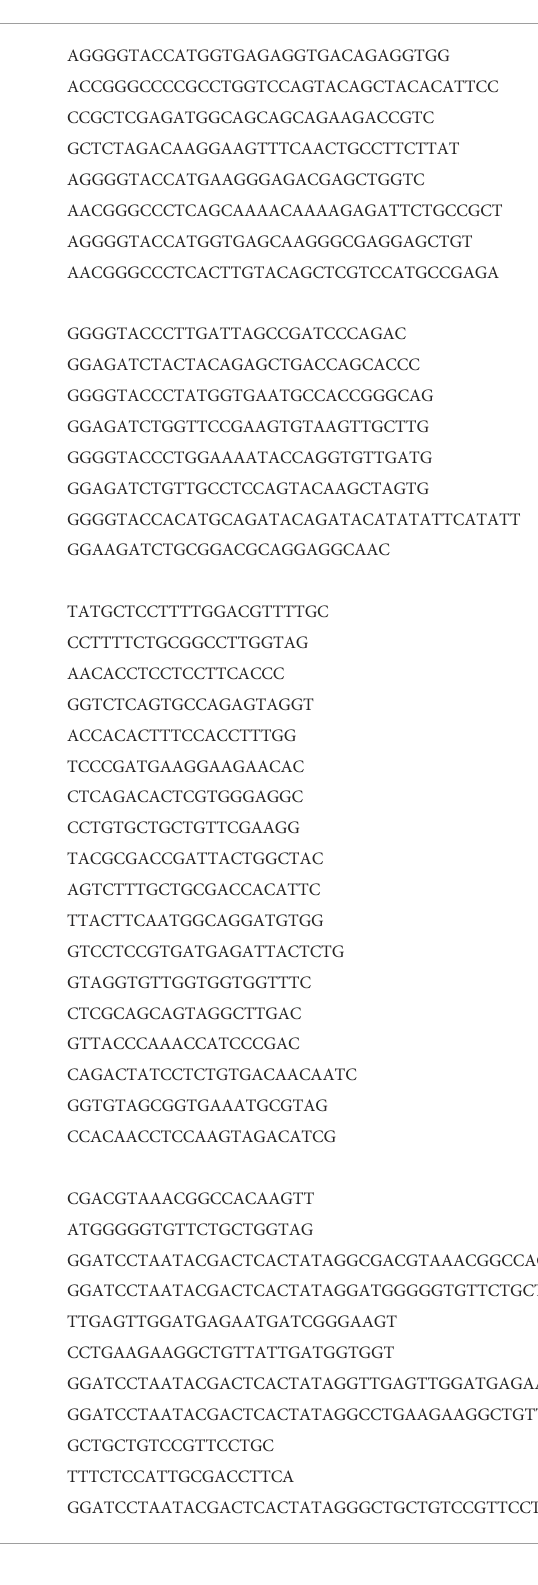
TABLE 1 Primers used in this